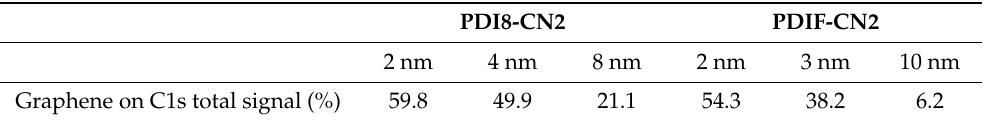
Table 1. Intensity of the C1s signal from the graphene substrate on the total C1s photoemission peak for PDI8-CN2 and PDIF-CN2 at different film